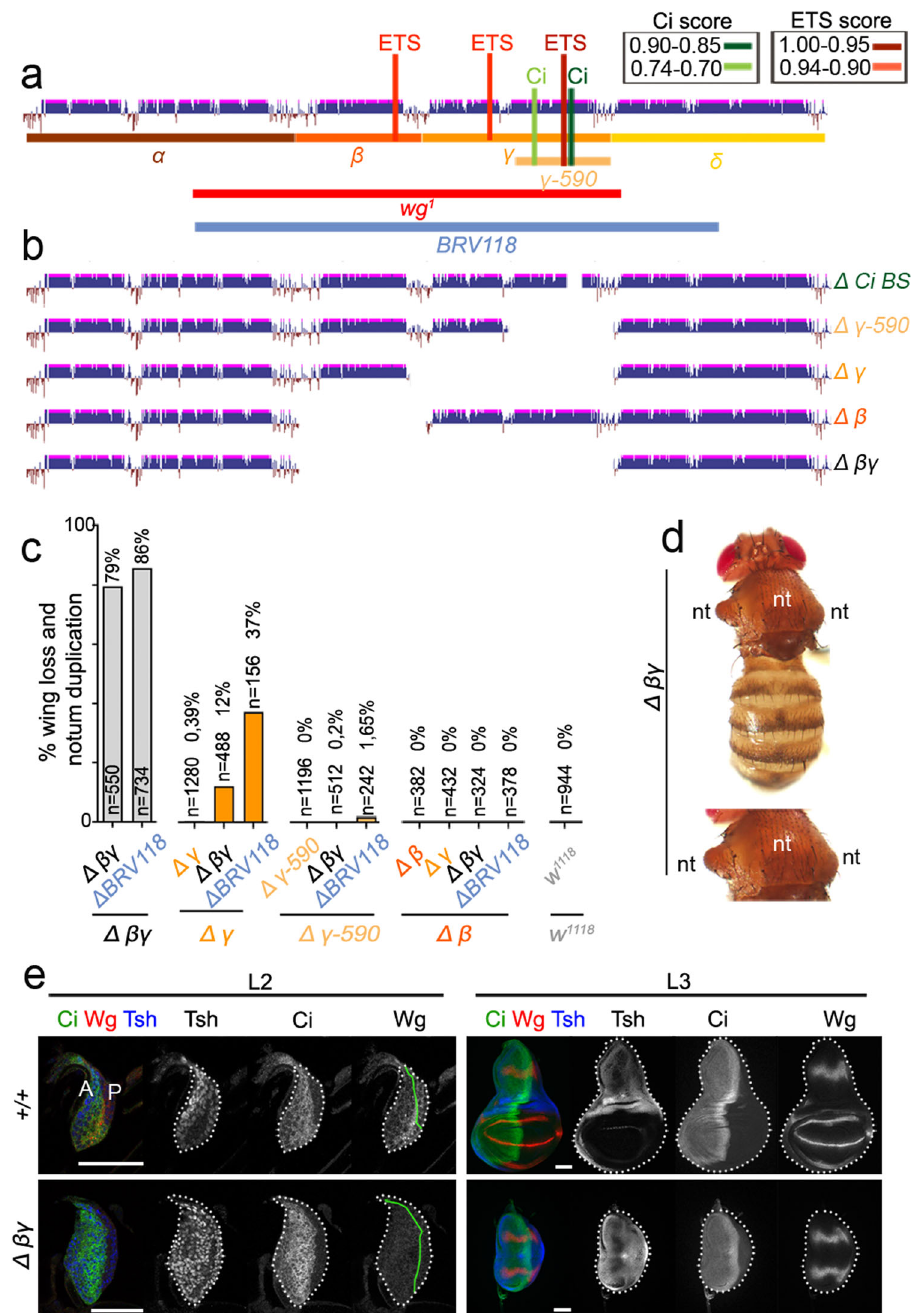
Fig. 4 | Functional redundancy within the wg 1 -enhancer to drive wing fate speci fi cation. a , b Cartoons depicting in a the evolutionarily conserved modules